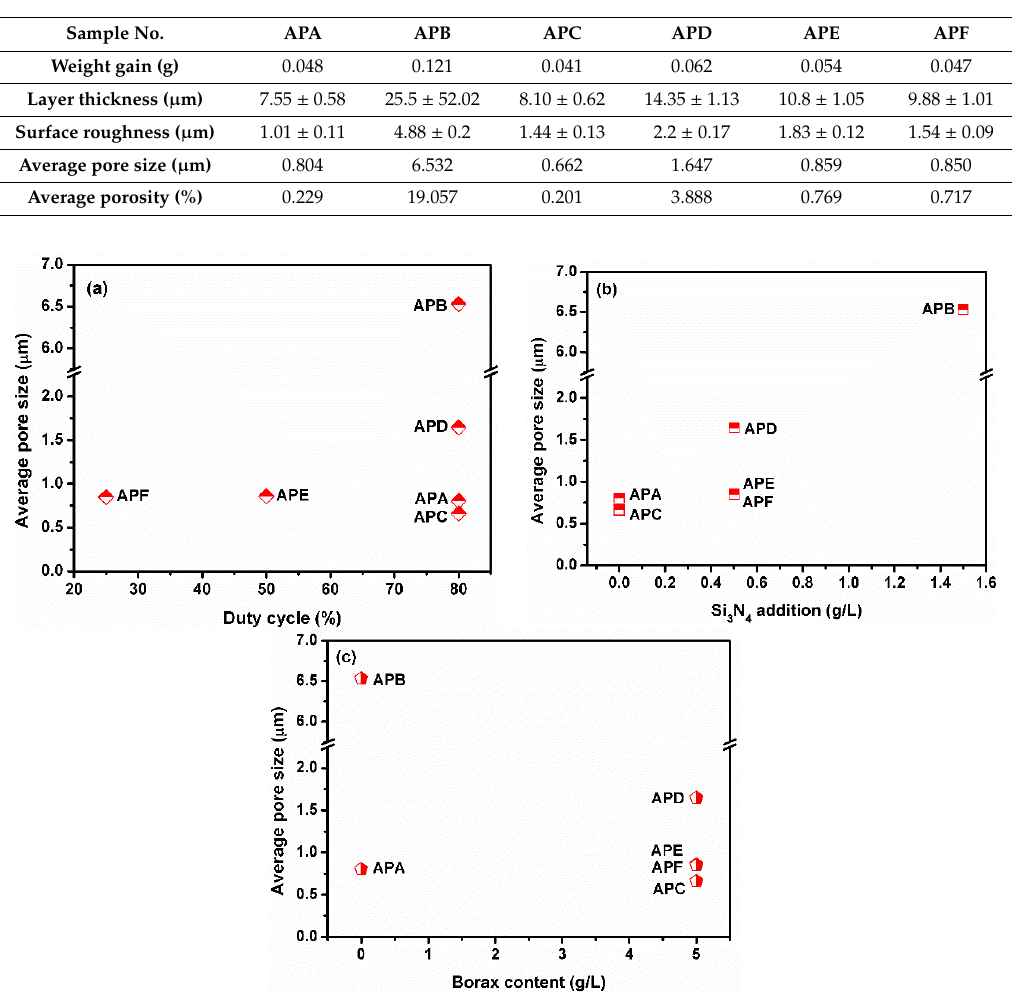
Table 3. Weight gain, layer thickness, surface roughness, average pore size, and average porosity of the PEO coatings.